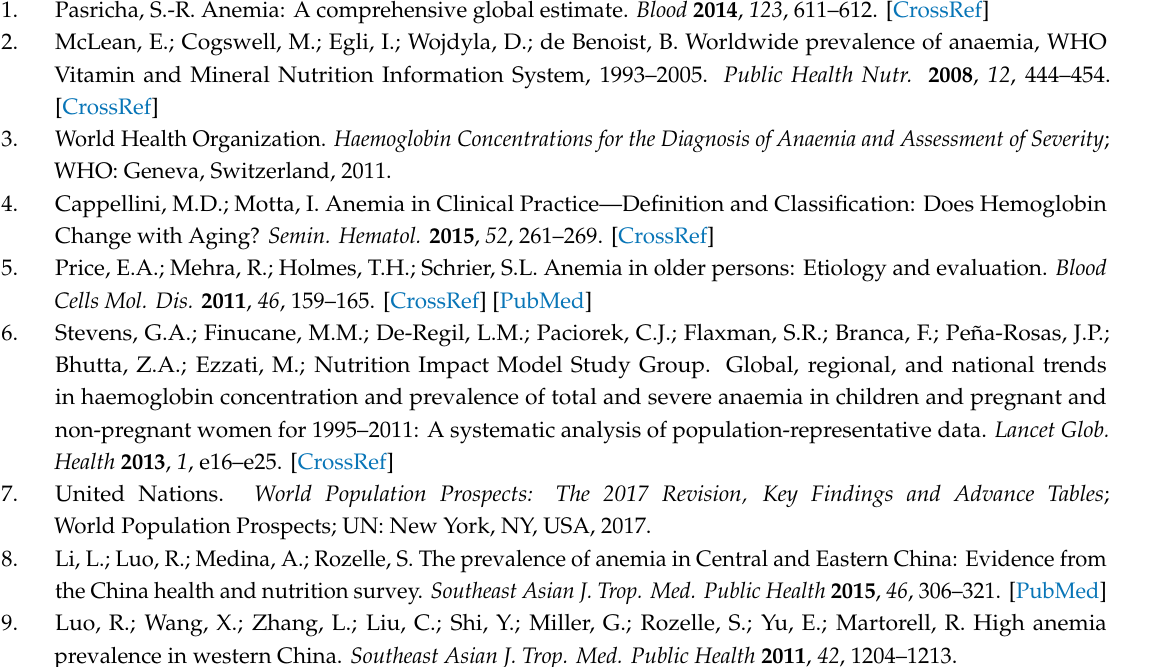
Table S1: Results of 10-fold cross-validation for PM 1 , PM 2.5 , PM 10 and NO 2 . Table S2: Annual average concentrations and pair wise correlations of air pollutants. Table S3: Characteristics of participants with haemoglobin blood samples data and without blood sample data. Table S4: Associations between 3-year pollutant moving averages and haemoglobin, by participant characteristics. Table S5: Sensitivity analysis of the association between anaemia prevalence and moving averages of pollutants. Figure S1: the association between an 10 ug / m 3 increase of PM and NO 2 and decrements in haemoglobin (g /